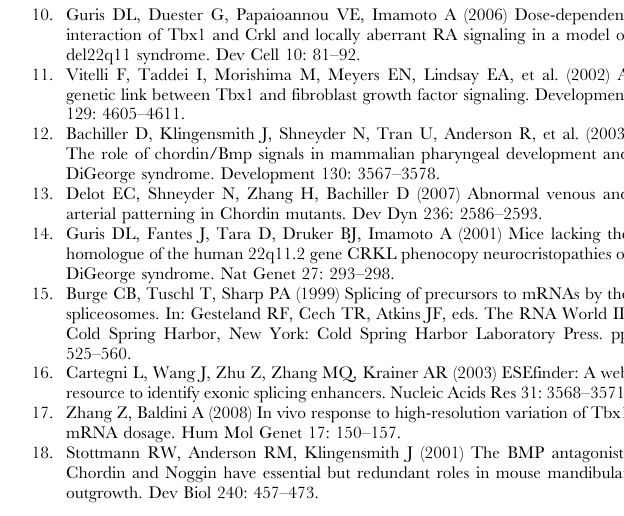
Table S1 Penetrance of mandible defect phenotype in Chrd mutant